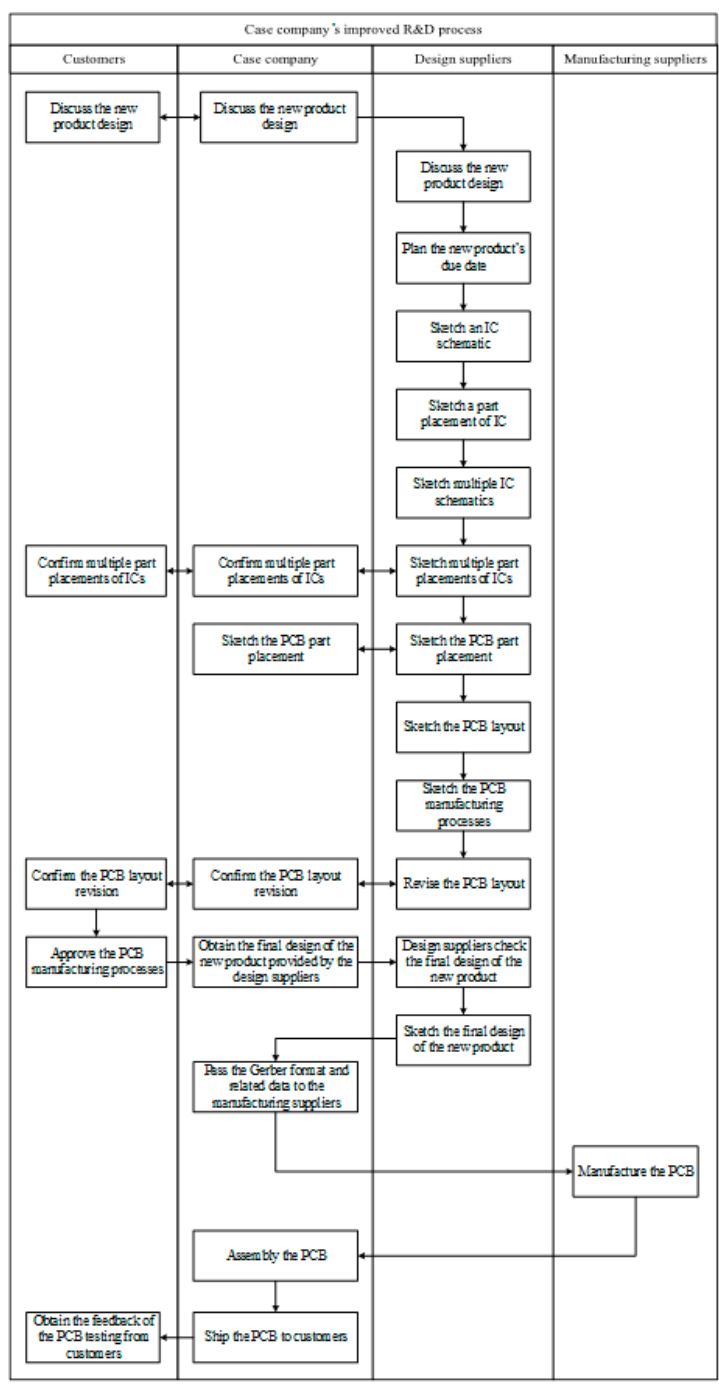
Figure 8. Improved R&D process across the case company’s PCB design chain.